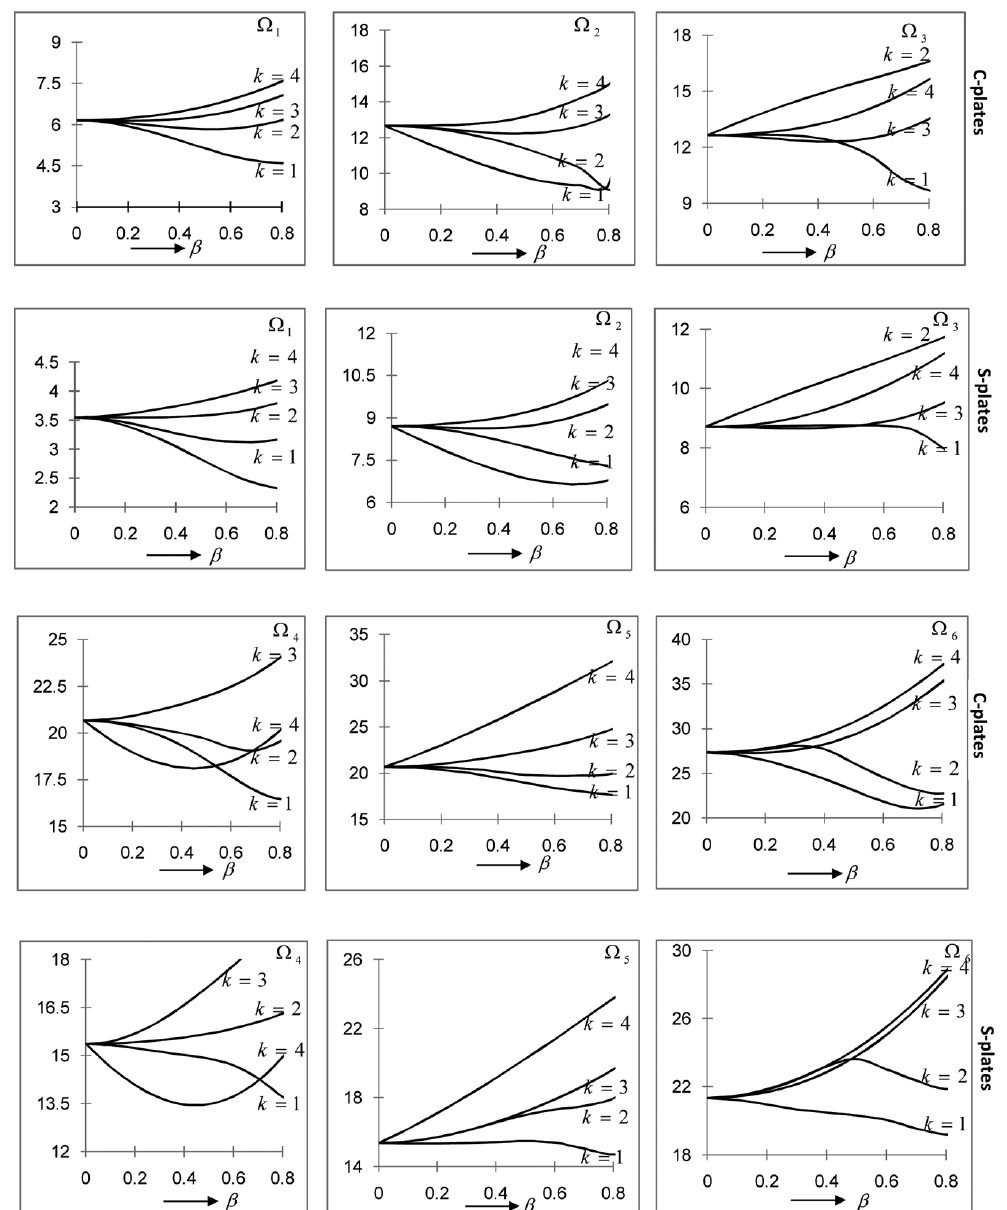
Fig. 4. Variation in Ω with β for corresponding C and S- plates when α = 0.5 and k = 1,2,3 and